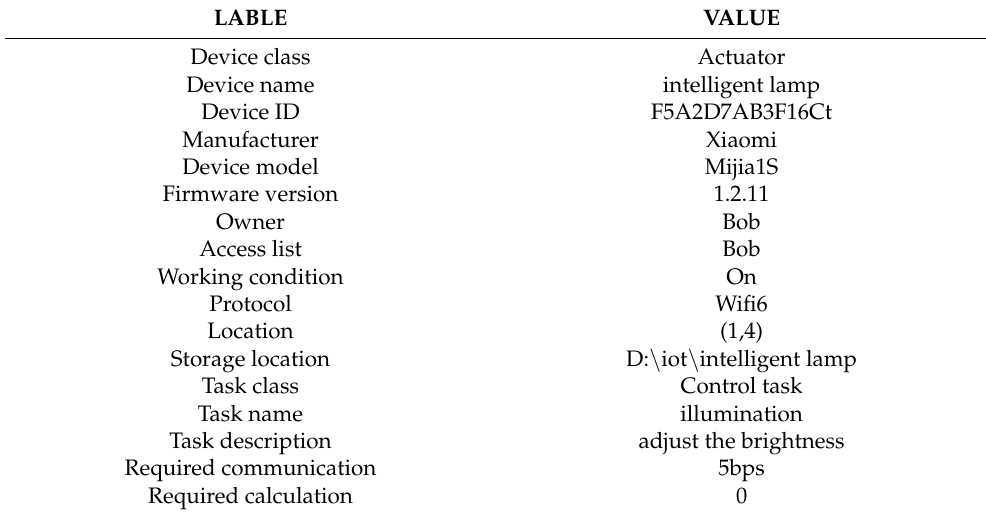
Table 1. Configuration information of the intelligent lamp.